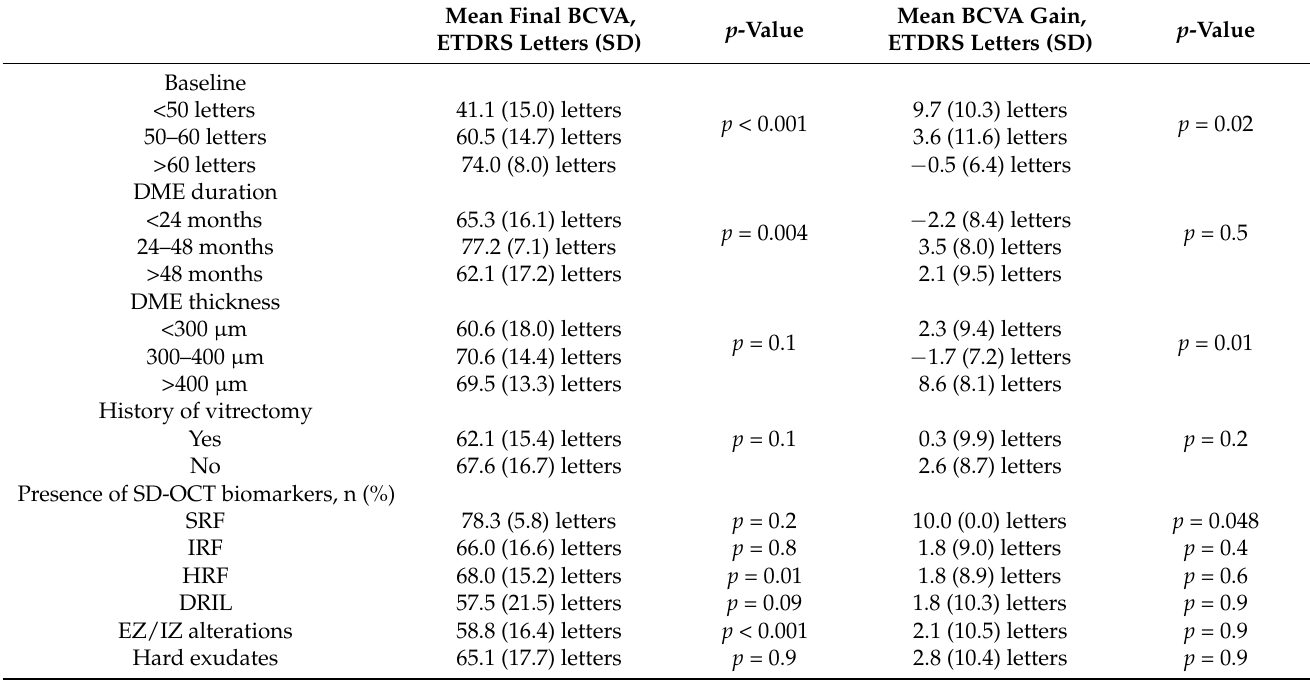
Table 2. Baseline associated factors for additional treatment after